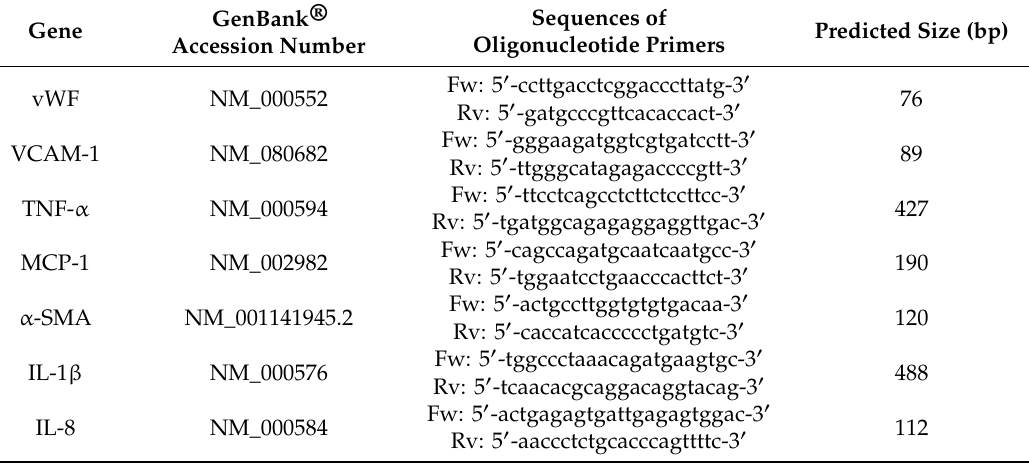
Table 1. The sequences of oligonucleotide primers used for evaluation of gene expression.